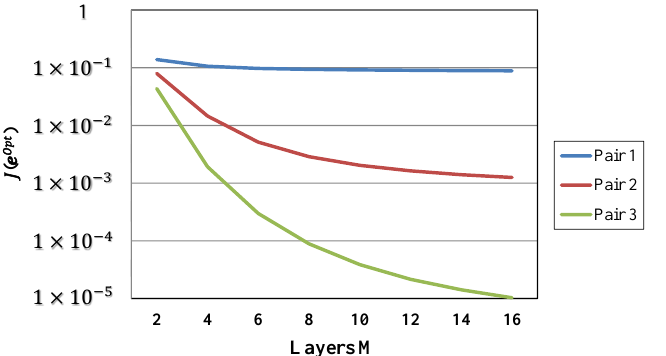
Figure 6. Three graphs of the dependence of the minimum value J opt ≡ J ( e opt ) of the cost functional J corresponding to the cloaking problem on the number of isotropic layers M for three different pairs ( ε ) given in min , ε max